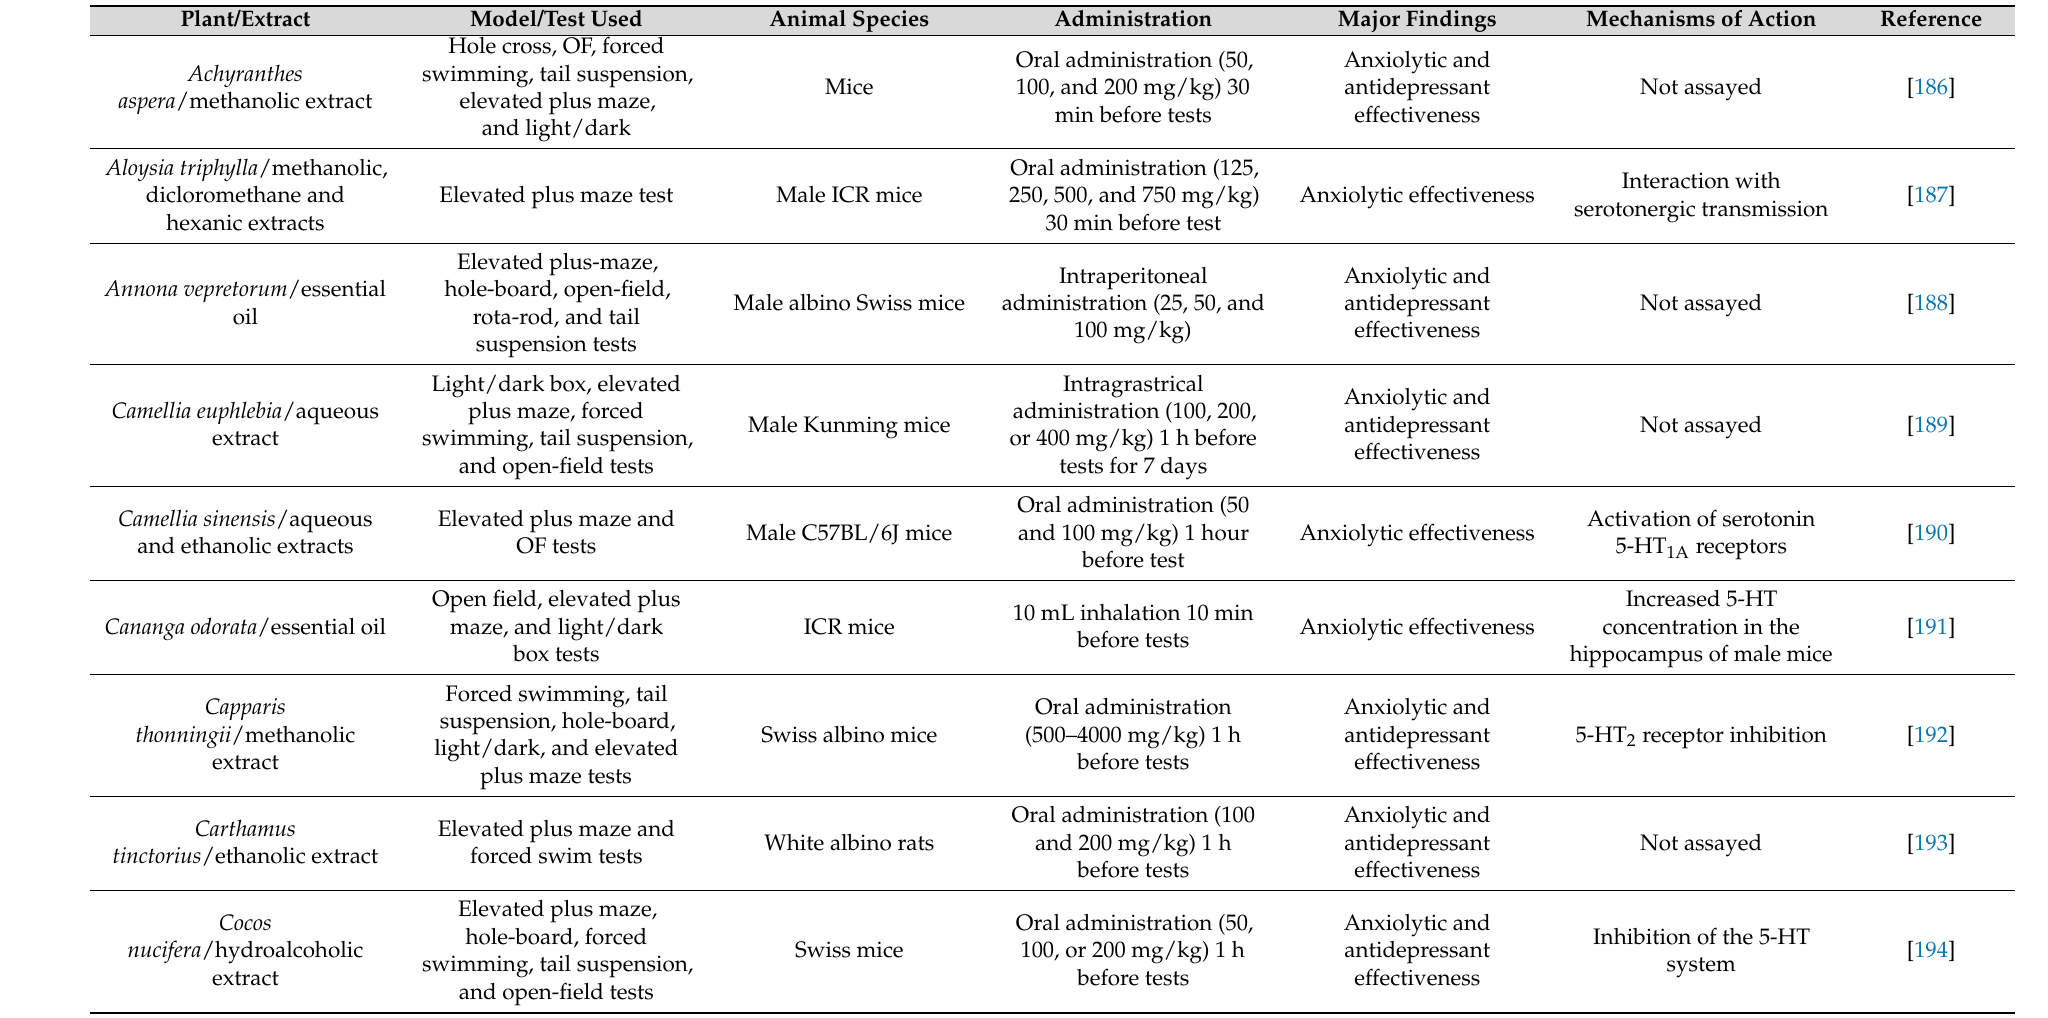
Table 2. Plant extracts that produce antidepressant-like and/or anxiolytic-like effects in animal